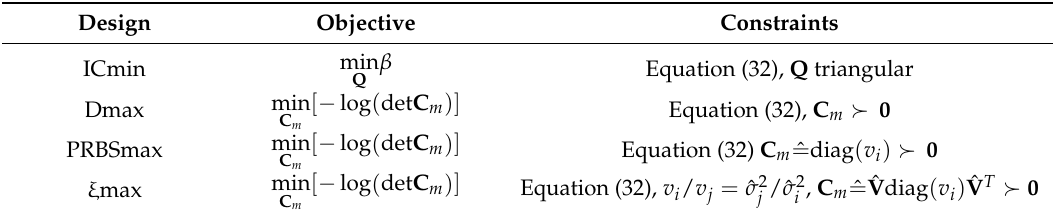
Table 2. Summary of designs tested on G 1 and G 2